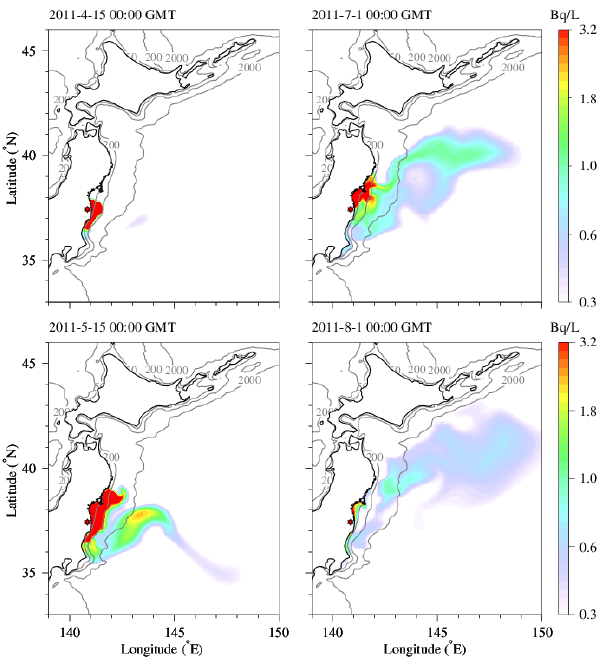
Fig. 12. Distributions of the high-resolution nested model computed surface 137 Cs concentration in Japan’s coastal region at 15:00GMT 15 April; 15:00GMT 15 May; 00:00GMT 1 July; and 00:00GMT 1 August 2011.